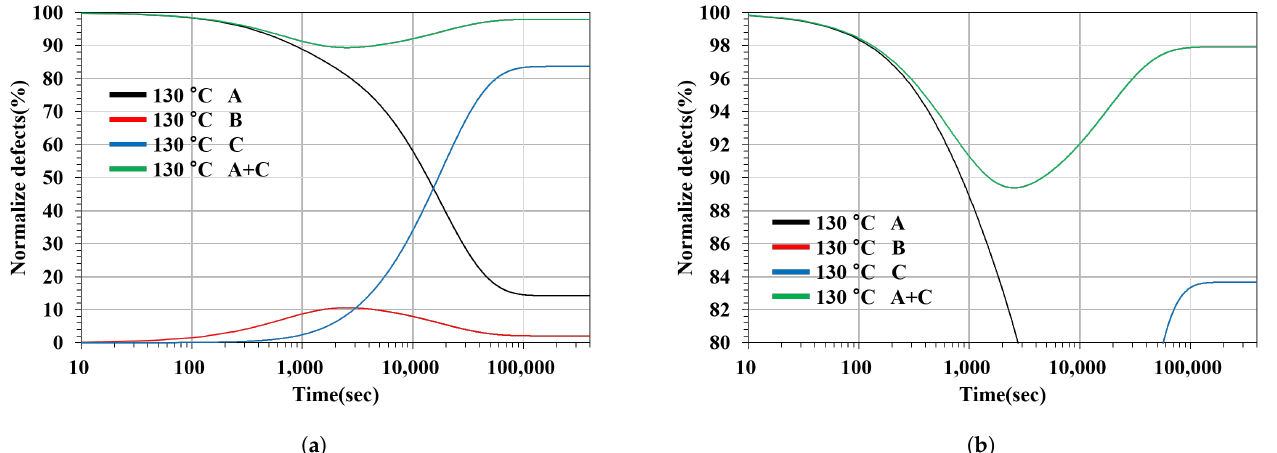
Figure 4. Numerical calculation results with kinetics model on cyclic reaction: ( a ) total reaction on full state with log timescale, and ( b ) combination reaction on double state (A + C) with log